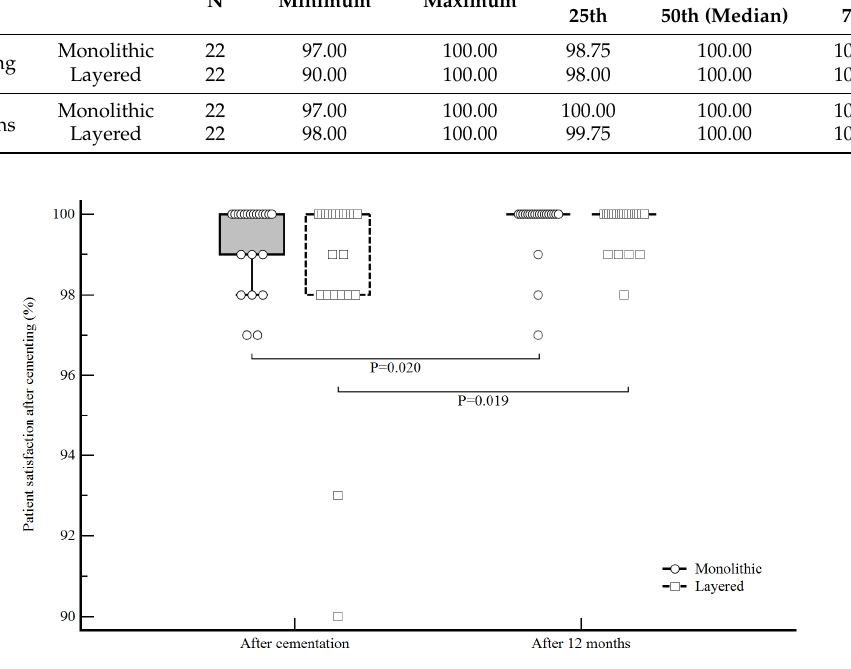
Table 5. Differences in patients’ aesthetic satisfaction between groups immediately and 12 months after the cementation: Mann–Whitney U test.